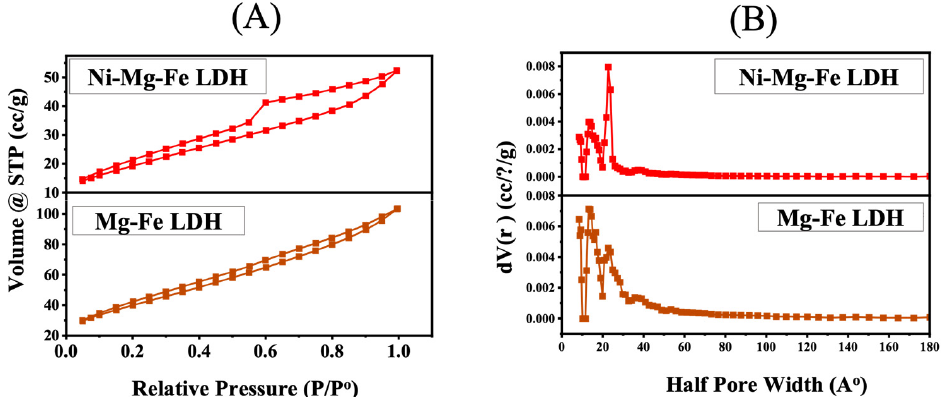
Figure 4. FTIR spectra of the Mg-Fe LDH and Ni-Mg-Fe LDH catalysts.